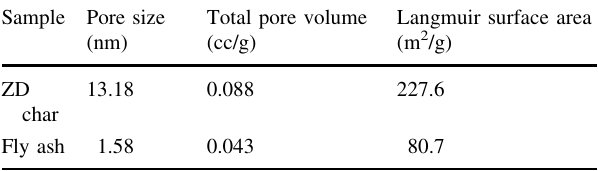
Langmuir surface area (m 2 /g)